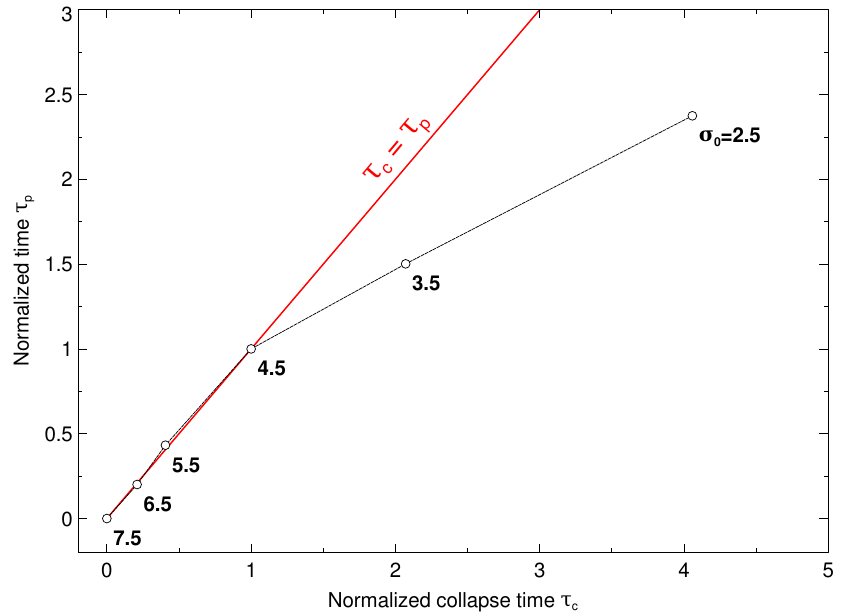
Figure 13. Comparison between the non-dimensional times τ c and τ p , respectively calculated from the Rayleigh collapse time as per Equation (4), and from the time difference between cavity maximum extension and pressure peak. Labels report the value of the cavitation number σ 0 . The red line represents τ c = τ p